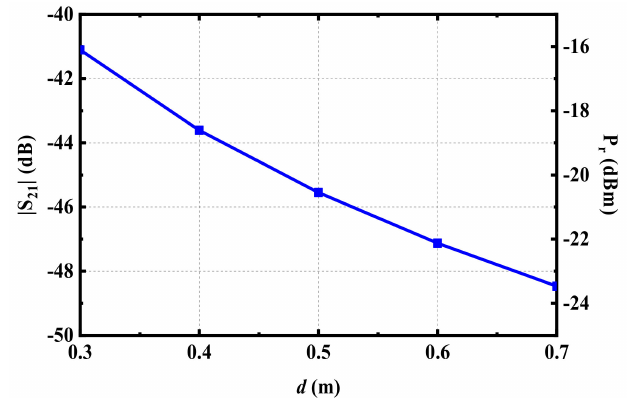
Figure 17. Evaluation of transmission efficiency and received